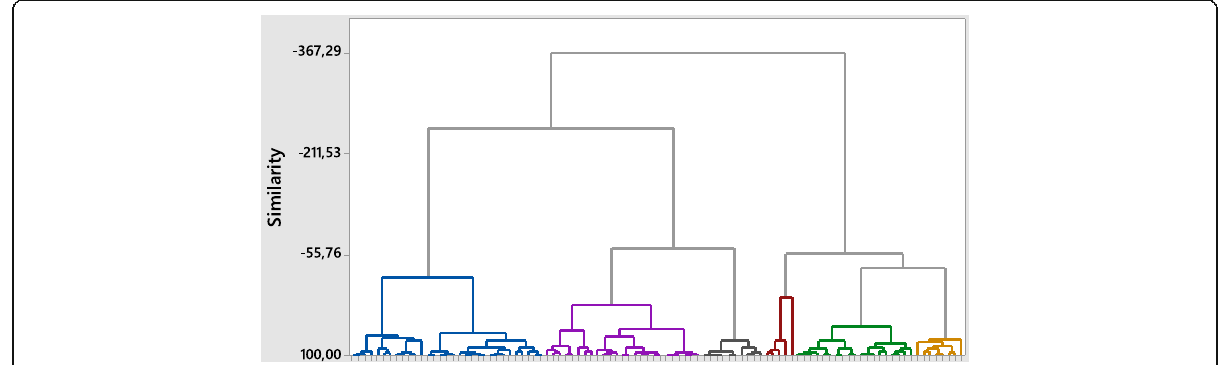
Fig. 3 Dendrogram of the existing network – Complete linkage - Euclidean Distance